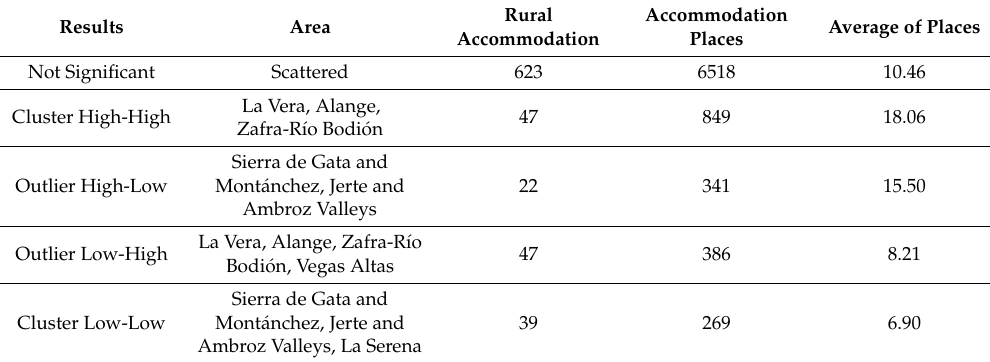
Table 4. Results of the cluster and outlier